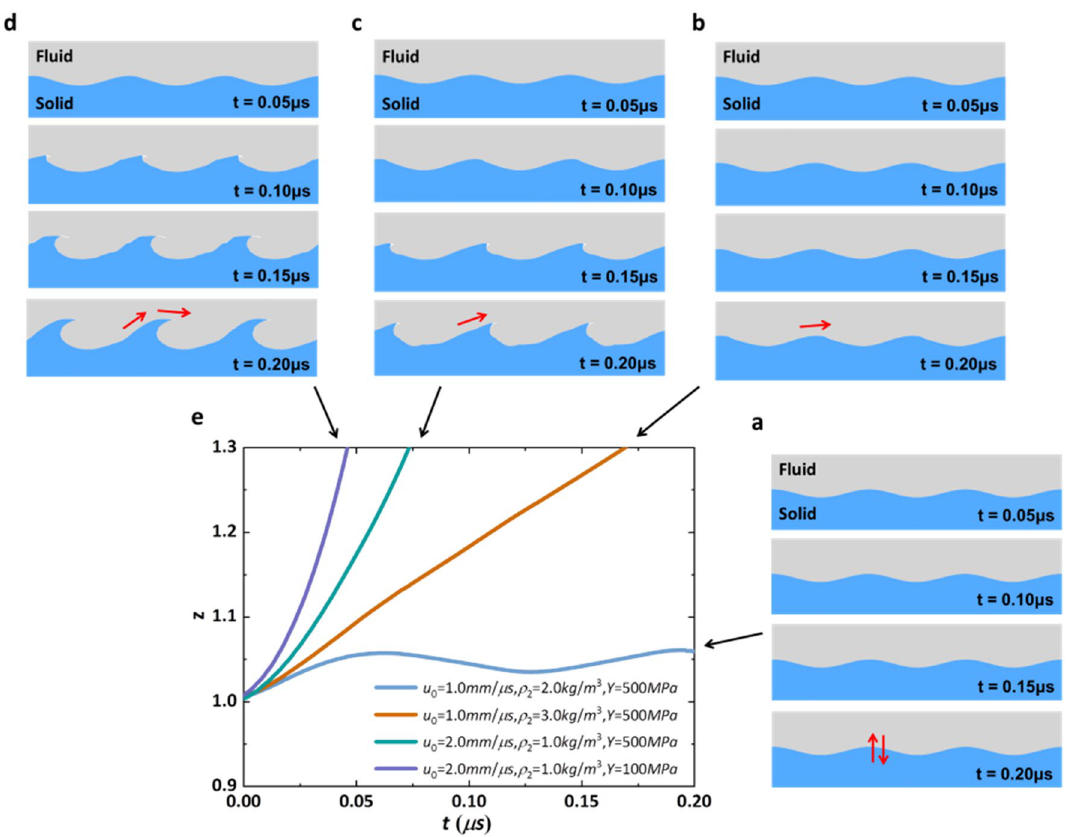
Figure 2. Four cases of surface temporal evolutions. ( a – d ) Maps of surface temporal morphologies of quiescent Cu plate surface (blue) flowed by ideal fluid H 2 O (grey) with tangential velocity u 0 , as calculated by finite element methods 23 . Each Cu plate has fixed density ρ 1 = 8.9 kg/m 3 , fixed shear modulus 39.39 GPa and the same initial perturbation with 250 μm wavelength and 10 μm amplitude. The four cases are obtained by varying tangential velocity, fluid densities and yield strength of Cu for case a u 0 = 1.0 mm/μs, ρ 2 = 2.0 kg/m 3 , Y = 500 MPa, case ( b ) u 0 = 1.0 mm/μs, ρ 2 = 3.0 kg/m 3 , Y = 500 MPa, case ( c ) u 0 = 2.0 mm/μs, ρ 2 = 1.0 kg/m 3 , Y = 500 MPa and case ( d ) u 0 = 2.0 mm/μs, ρ 2 = 1.0 kg/m 3 , Y = 100 MPa. Surface morphologies of four cases at time 0.05 μs, 0.1 μs, 0.15 μs, 0.2 μs are given respectively. The red arrow in each surface at time 0.2 μs is the schematic of surface motion direction. ( e ) The growth factor z of each case is extracted from simulation.